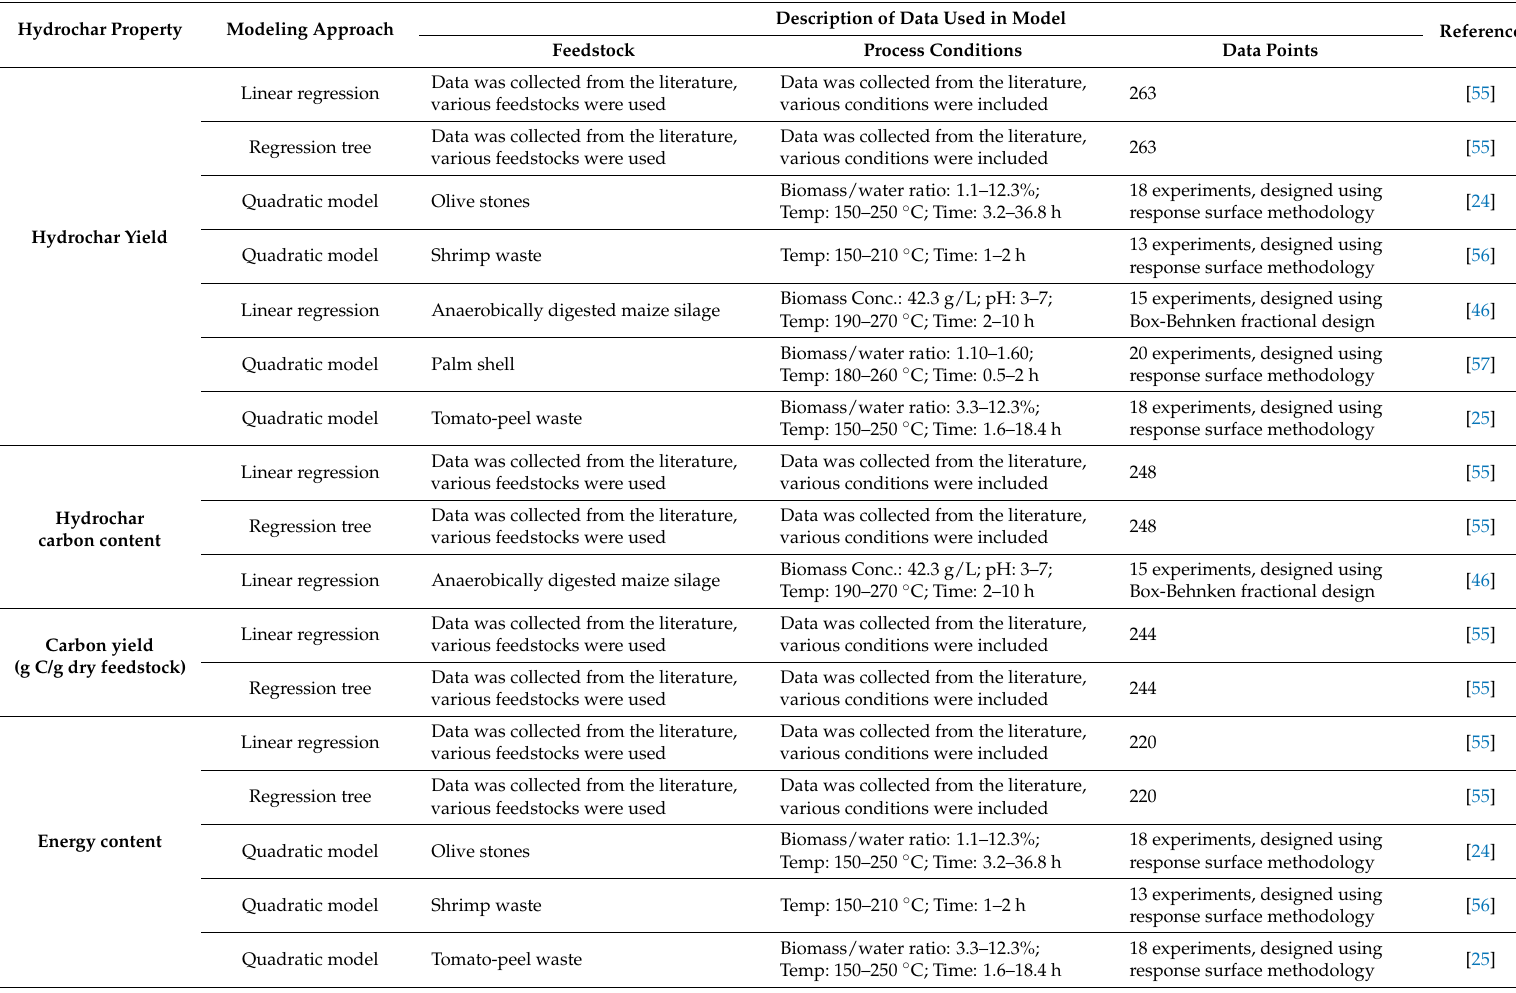
Table 2. Summary of Statistically Based Models Predicting Hydrochar